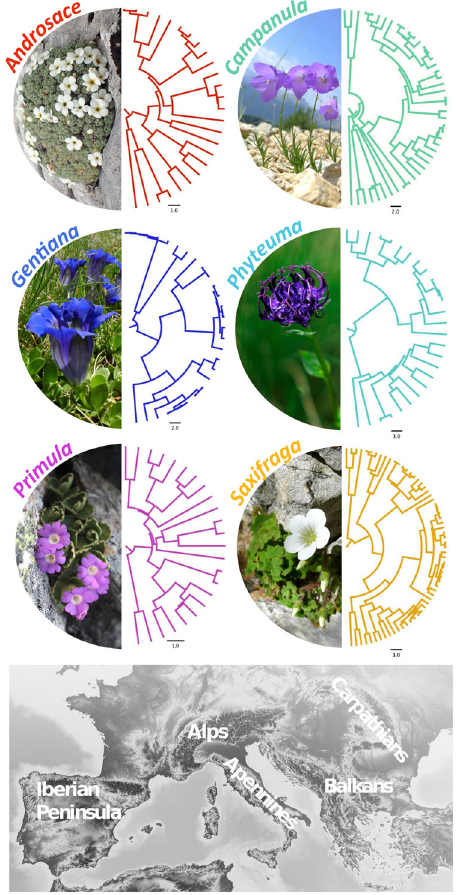
Fig. 1 Map of the European mountain system depicting the fi ve major geographic regions and the six mountain plant lineages that notably diversi fi ed in European mountains. 84% of all species from these lineages was sampled in this study and we sampled across all fi ve mountain regions. The colors used for the six different phylogenies are used accordingly throughout following fi gures. The timescale unit of phylogenetic branch lengths is Ma. The background map is adapted from